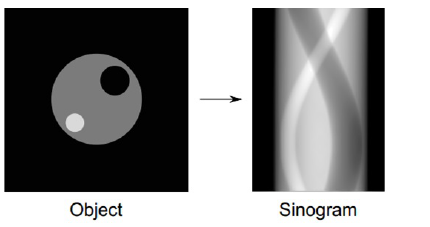
Figure 1. A simple object and the